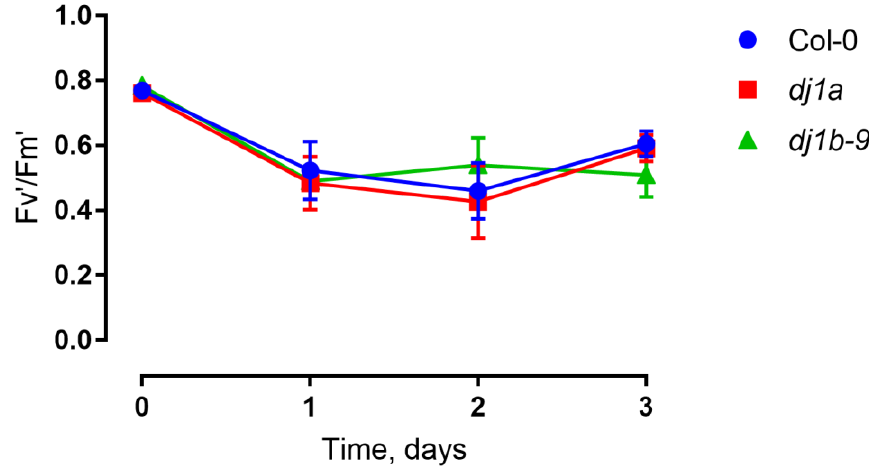
Figure 6. Photosystem II efficiency of mutants subjected to high light treatment was the same as that of wild type (WT). Three-week-old plants were exposed to high light intensities (600 µ mol · m − 2 · s − 1 ) for 72 h and the Fv’/Fm’ ratios were measured. Each data point represents average from biological triplicates ± SD.